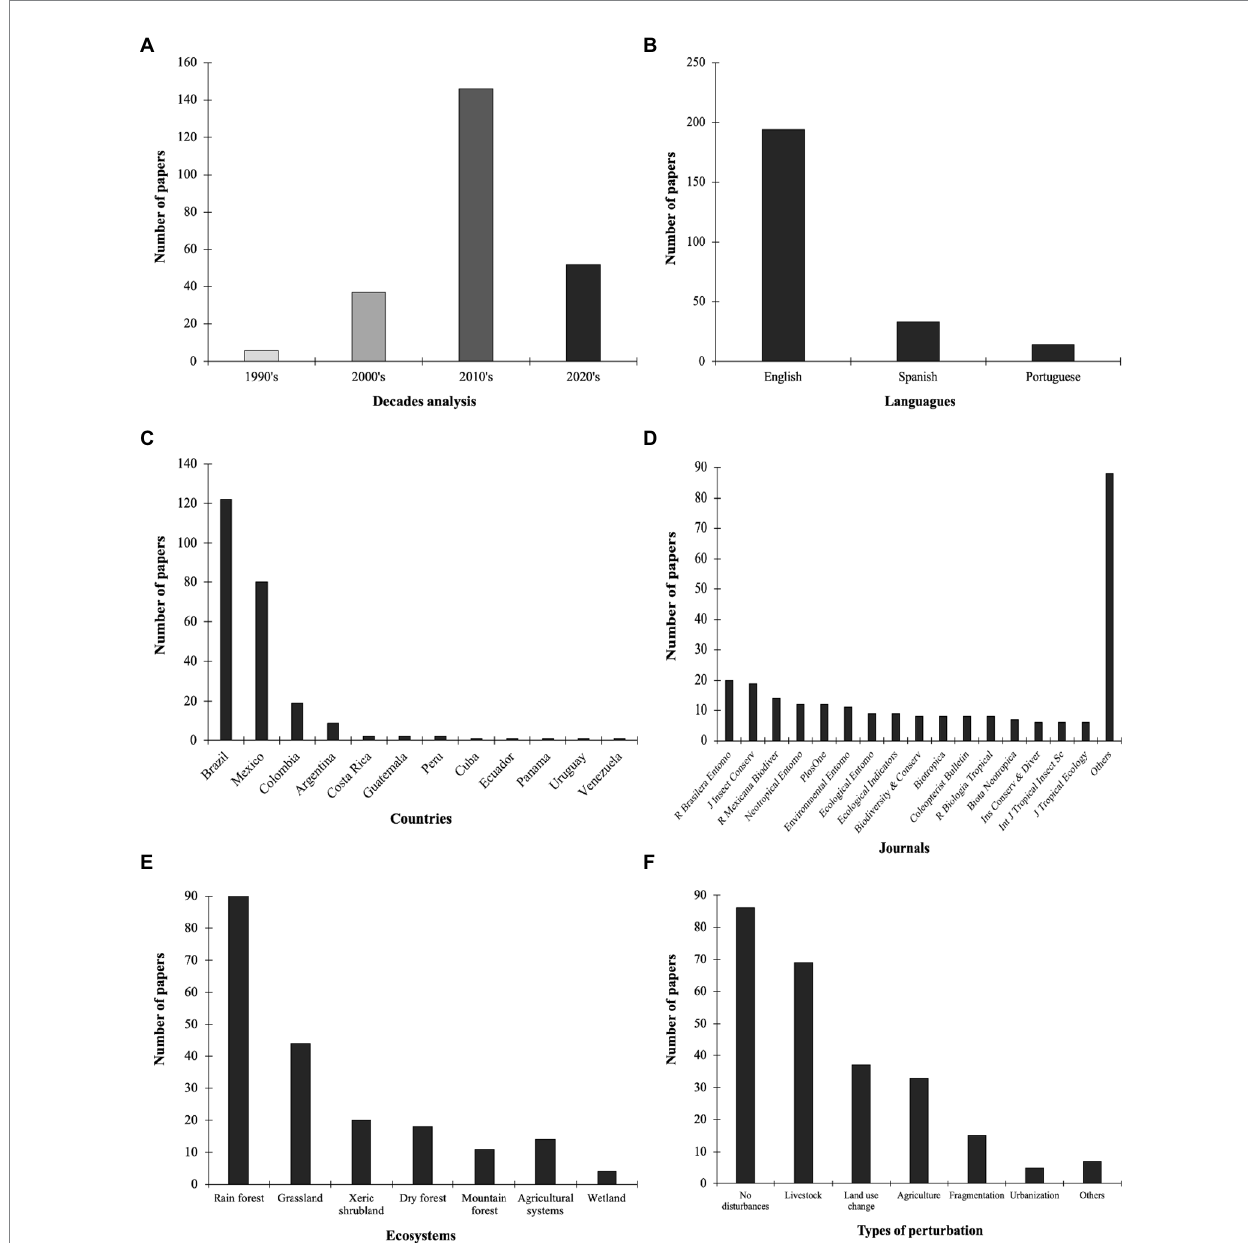
FIGURE 2 Number of published papers on dung beetle sampling compiled in the Neotropics according to different variables: (A) Decades analysis; (B) Languages; (C) Journals; (D) Countries; (E) Ecosystems; and (F) Types of